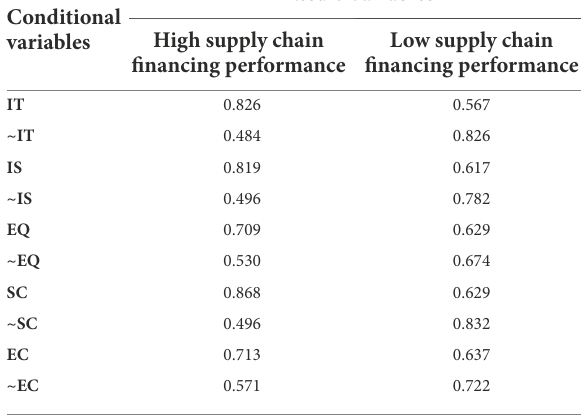
TABLE 4 Results of necessity tests for individual conditions.